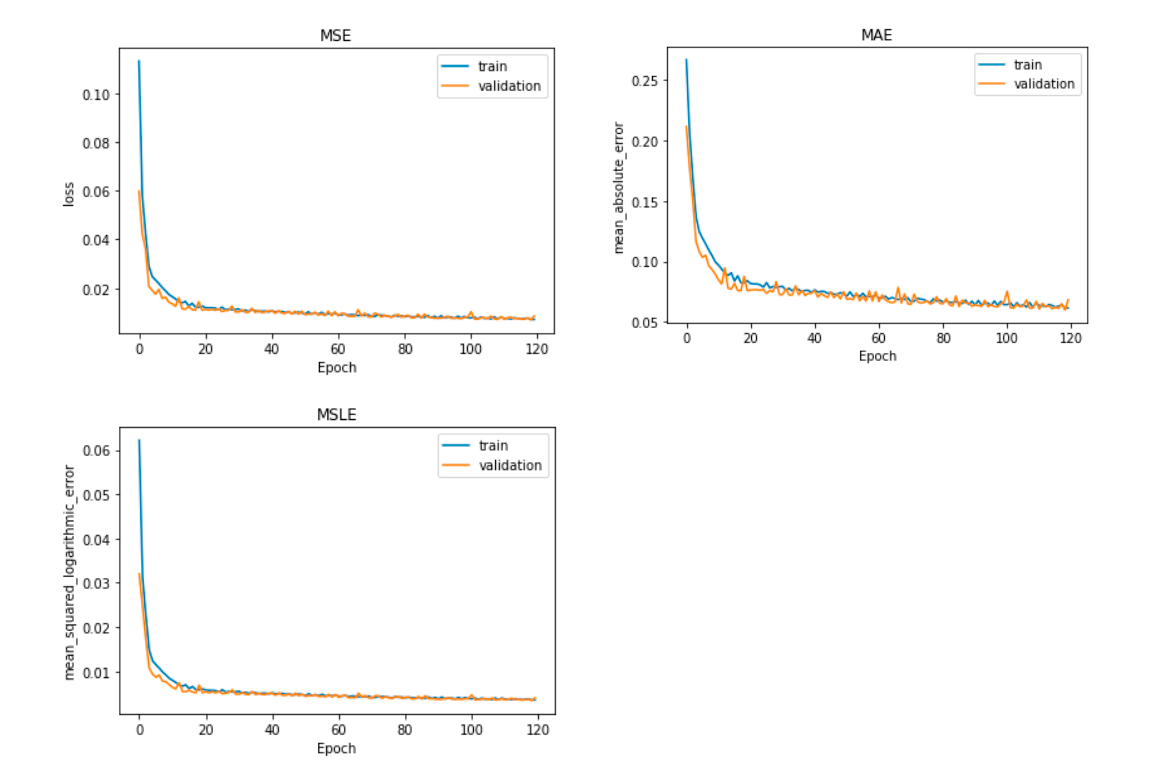
Figure 7. Multiple inverters and model predictions with the same A-11 feature variable information (BiGRU).